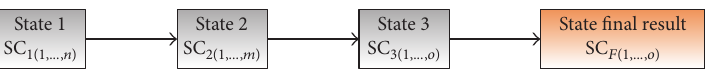
Figure 7: State model with final state (final result).